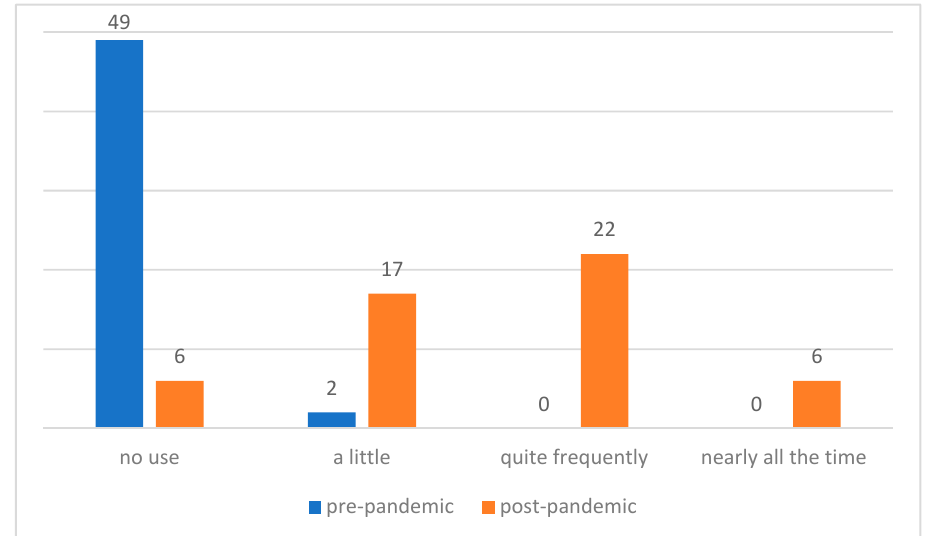
Figure 2. Number of SLPs who used telepractice before and during the COVID-19 pandemic in the December 2020 survey ( n = 51). Table 2. Clinician perception to telepractice as reported in the December 2020 survey ( n = 51).